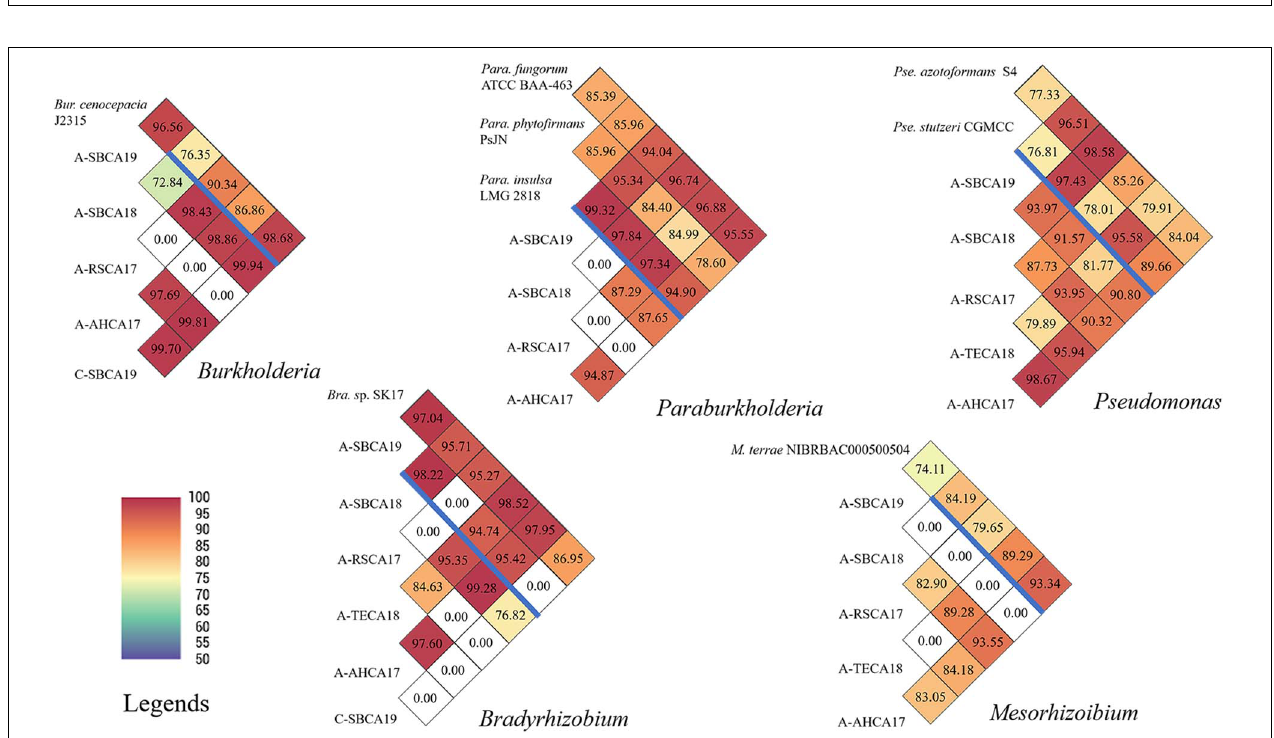
FIGURE 4 | Pairwise ANI comparisons of draft genomes of Burkholderia , Paraburkholderia , Pseudomonas , Bradyrhizobium , and Mesorhizobium strains from ACP and citrus leaf samples from southern California. Draft genome sizes are listed in Supplementary Table 2 . Reference genomes are listed above the blue bar. ANI values are also coded in color as explained in the legends. ANI was calculated based on fragment size of 500 bp.